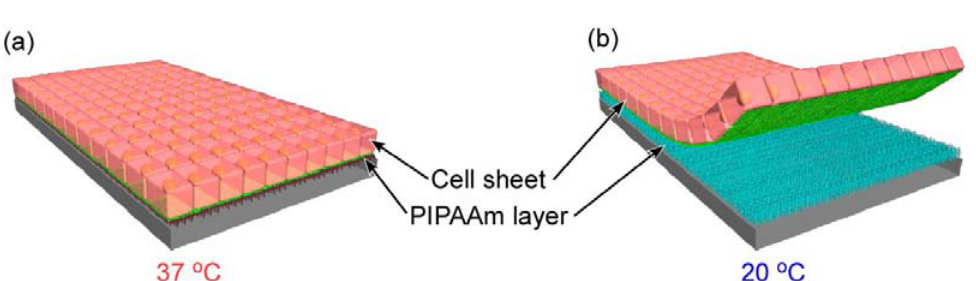
Figure 1. The schematic illustration of cell sheet on poly( N -isopropylacrylamide) (PIPAAm) modified surface. ( a ) At 37 °C, cells adhere on dehydrated PIPAAm layer; ( b ) At 20 °C, cells detach from hydrated PIPAAm layer, and form an intact cell